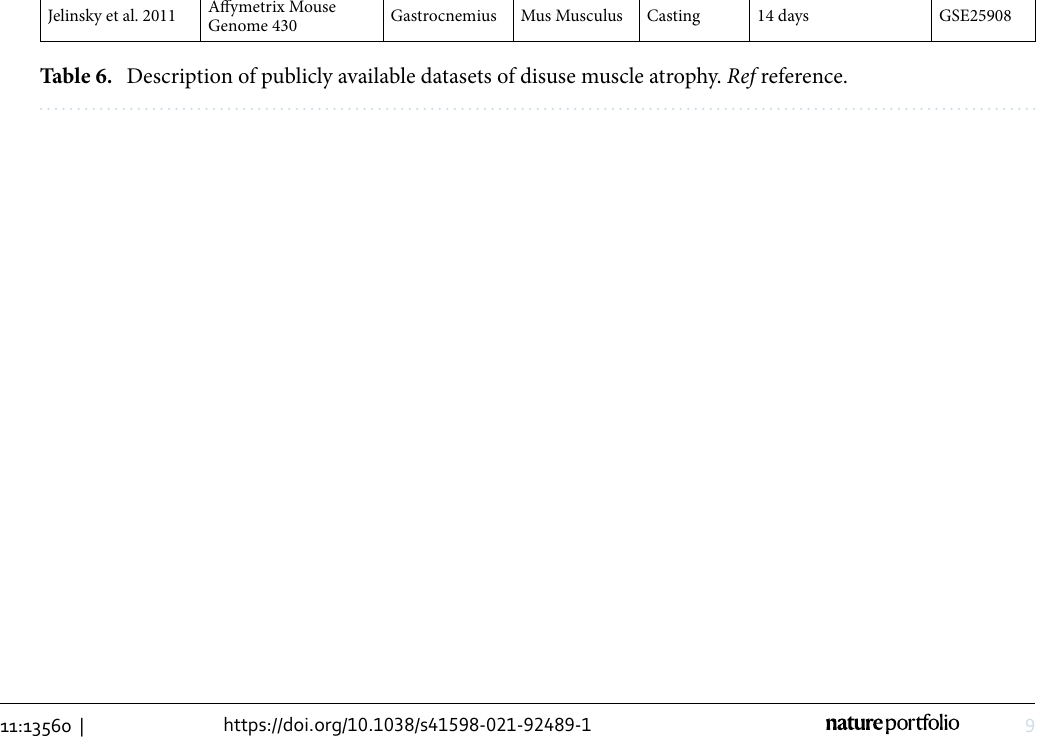
Authors Platforms Muscle Organism Experiment Intervention duration